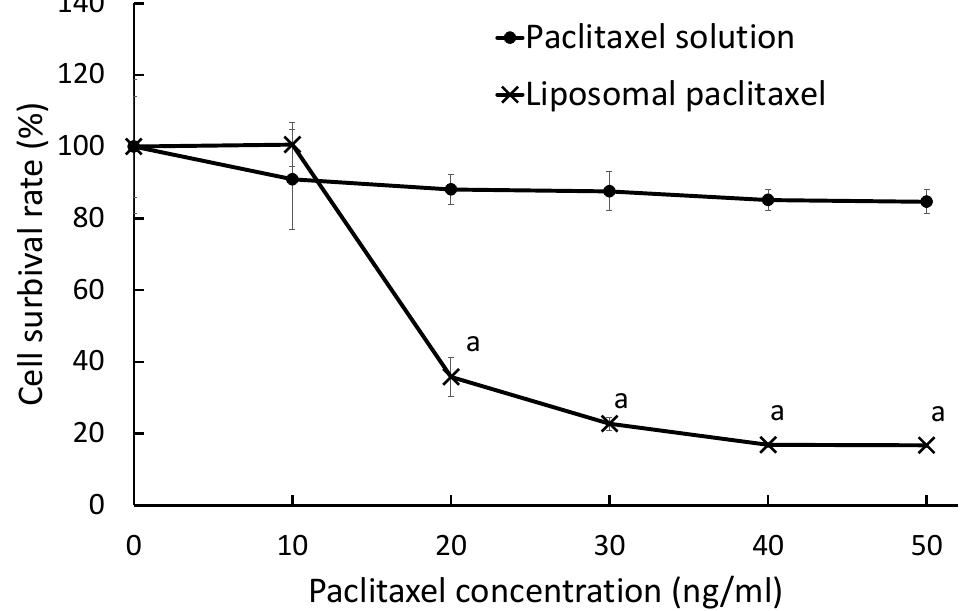
Figure 1. Effect of gelation of paclitaxel on cell viability. P388 leukemia cells (1 × 10 5 cells/mL) were incubated in a 5% CO 2 incubator at 37 °C for 24 h, and then paclitaxel solution or liposomal paclitaxel was added. After 48 h of incubation, cell viability was calculated using a colorimetric test using cell counting kit-8. Data are expressed as the mean ± SEM of n = 4–8. Significant difference from paclitaxel solution is a: p < 0.001.